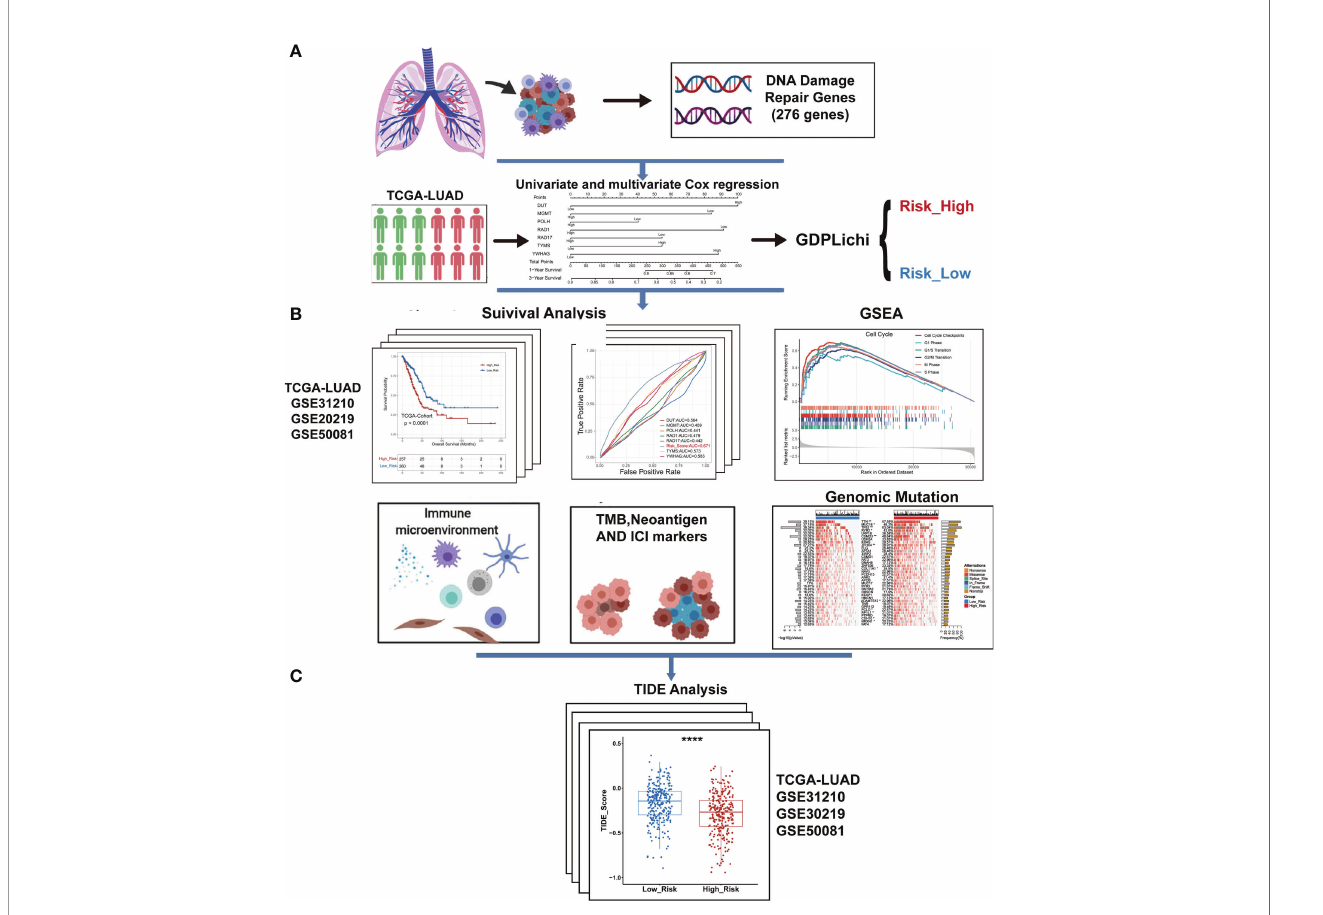
FIGURE 1 | The overall work fl ow of GDPLichi. (A) GDPLichi was constructed by DNA damage-related genes and divided LUAD patients into two subgroups (low- and high-risk). (B) GDPLichi can be used for the analyses of survival, GSEA, immune microenvironment, TMB, Neoantigen, immune checkpoint genes (PD-L1, PD-1, CTLA4), and genomic mutation between low- and high-risk subgroups. (C) The TIDE algorithm was used to predict the sensitivity to immune checkpoint inhibitors (ICIs) between low- and high-risk groups in four